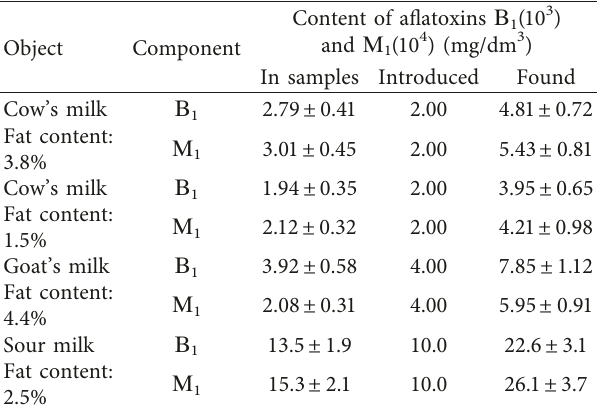
1 on the GCE: the